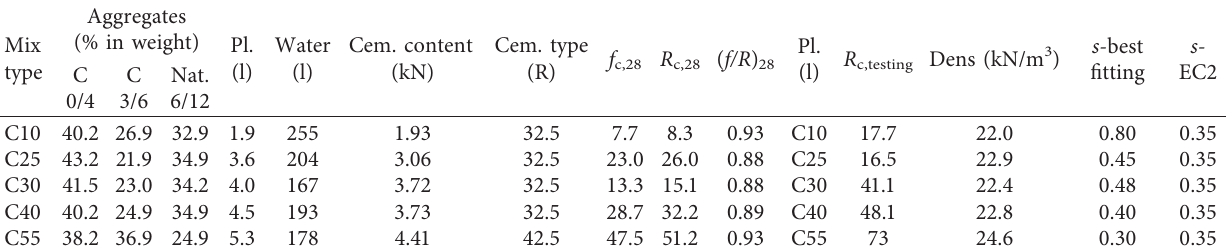
Table 1: Concrete mix characteristics. See equation (1) for the meaning of the